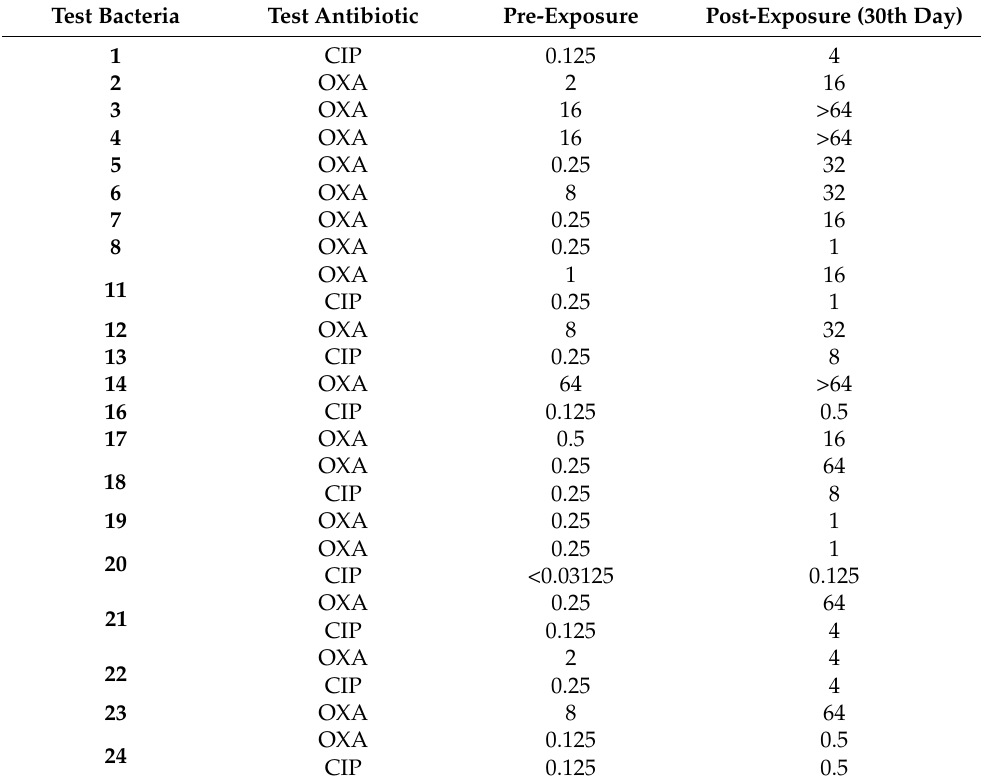
Table 6. MIC values of the test bacteria before and after exposure to the test antibiotics ( µ g/mL). Test Bacteria Test Antibiotic